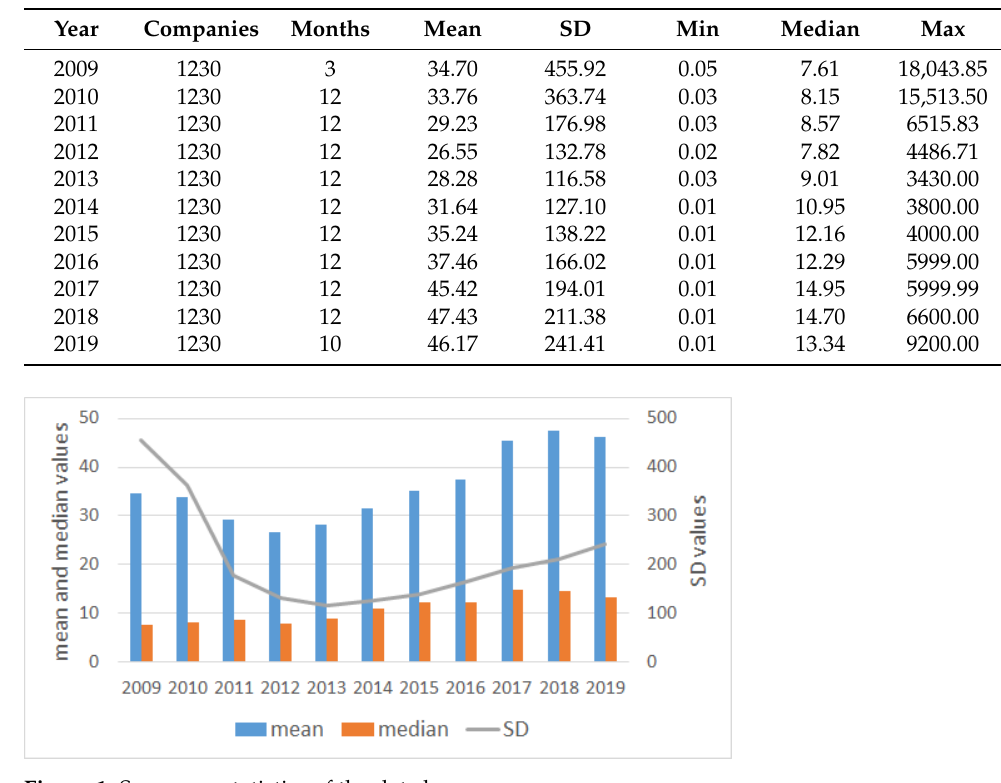
Table 1. Summary statistics of the data by year.